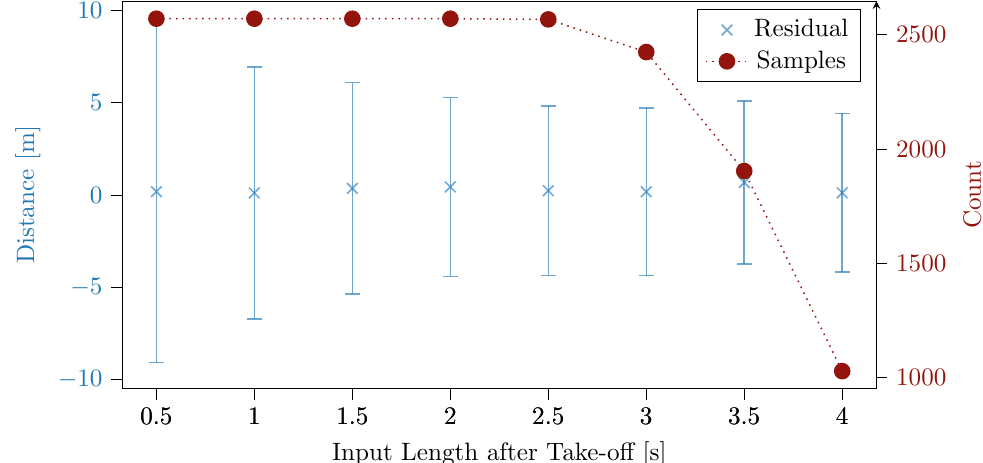
Figure 5. The left y-axis corresponds to the prediction accuracy for ResNets trained on various input lengths after the athlete’s take-off. In blue, the mean of the residual is plotted with the standard deviation of the residual as the y-error bar. Additionally, the number of jumps with a minimum duration, as shown on the x-axis, is plotted in